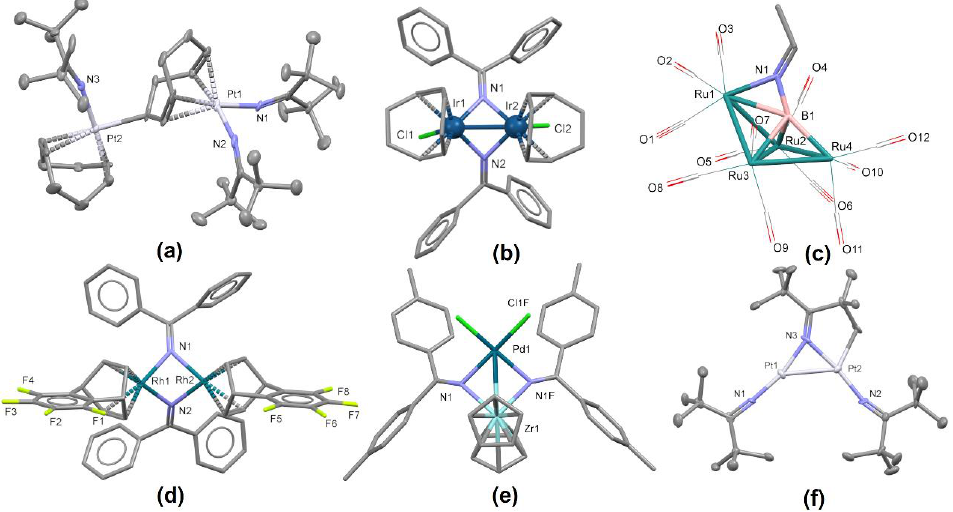
Figure 3. ( a ) Binuclear complex of Pt(II) with monodentate κ 1 -N ketimine ligands and activated 1,5-cyclooctadiene fragment acting as an intermetallic bridge [113] (CSD Refcode MOYJES); ( b ) binuclear complex of Ir(II) with ketimine as an intermetallic bridge and 1,5-cyclooctadiene ligands located on the outside of the coordination unit [116] (CSD Refcode KABLOP); ( c ) bridging µ 2 - κ 2 ethanimine ligand in metallaborane tetra-ruthenium cluster with boron–nitrogen coupling [117] (CSD Refcode PORSUK); ( d ) binuclear complex of Rh(II) with ketimine bridging ligand [118], shown only one symmetrically independent molecule (CSD Refcode LIFMIW); ( e ) heterobimetallic Zr / Pd complex with ketimine linkage [119] (CSD Refcode WAGHOC) and ( f ) binuclear complex of Pt(II) stabilized by ketimine ligand with very short Pt–Pt distance and activated C–H bond [113] (CSD Refcode MOYHUG). Solvent molecules and hydrogen atoms were omitted for